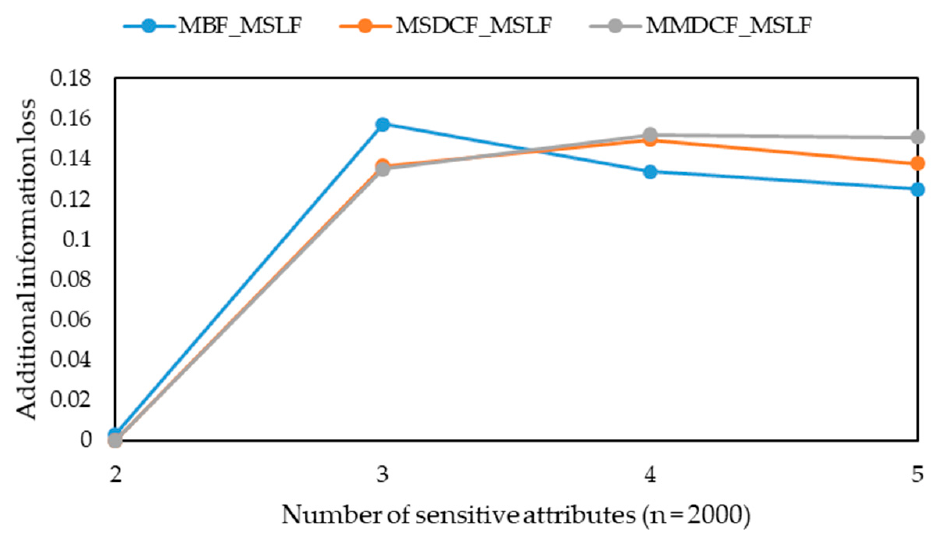
Figure 22. The additional information loss of MBF-MSLF, MSDCF-MSLF and MMDCF-MSLF with di ff erent sensitive attribute numbers ( n = 2000).